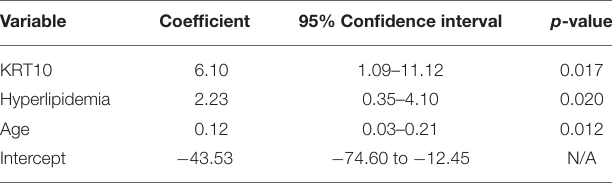
TABLE 2 | The estimated coefficients in the prediction model.